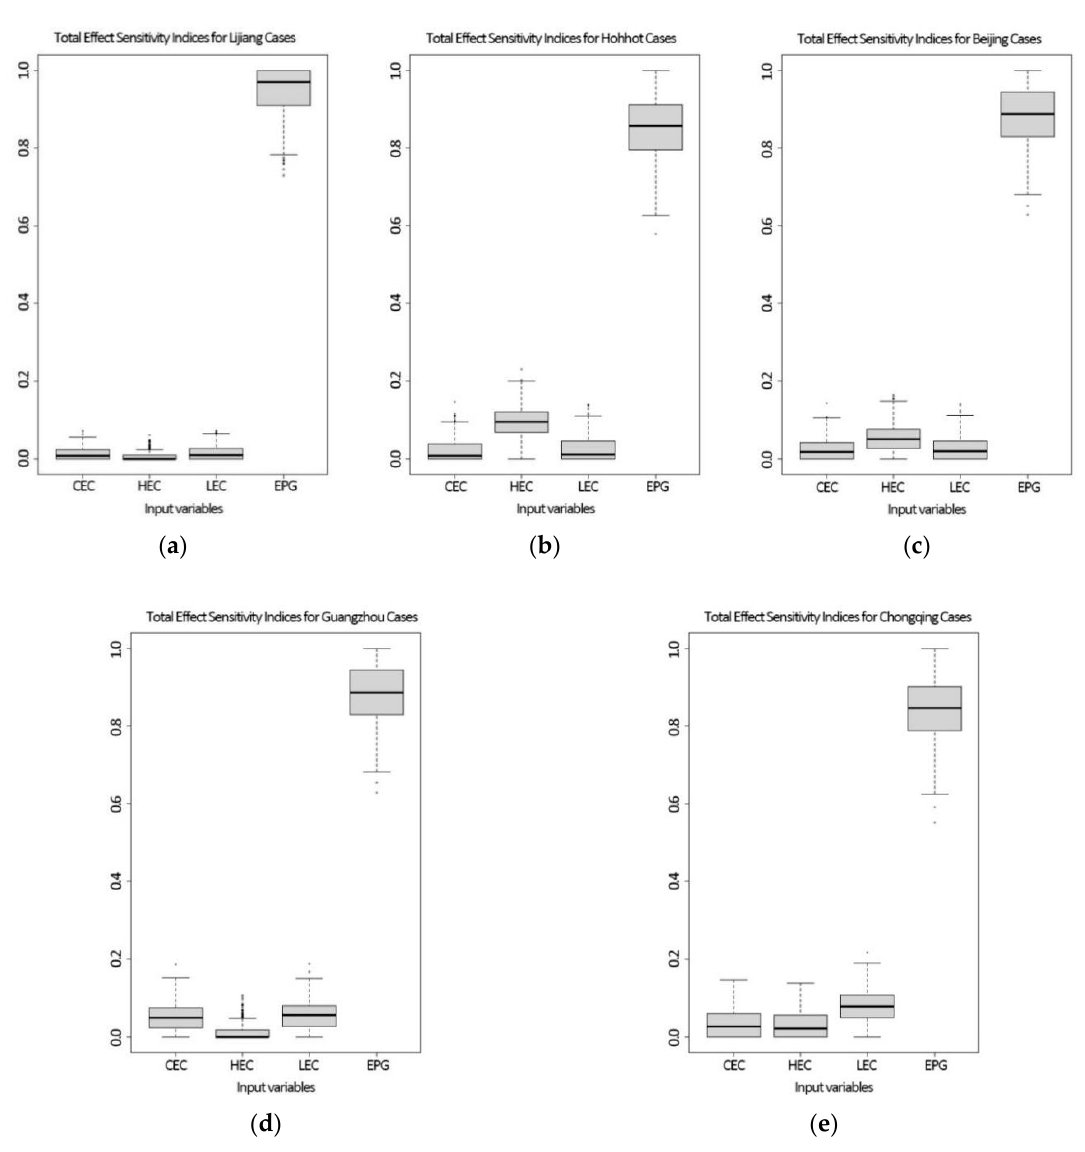
Figure 9. Sensitivity analysis of each component of the STVP energy performance on flat roofs to the ESR. ( a ) Case 1: Lijiang; ( b ) Case 2: Hohhot; ( c ) Case 3: Beijing; ( d ) Case 4: Guangzhou; ( e ) Case 5: Chongqing.